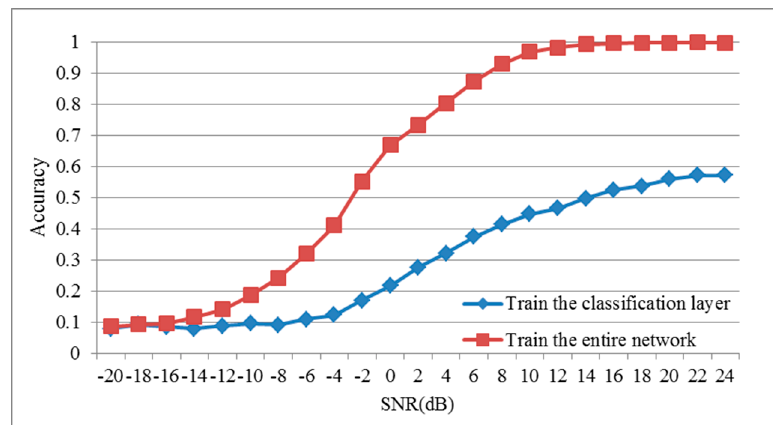
Figure 4. Performance comparison between training the entire network and training only the classification layer. The classification method is signal rearrangement method (SRM), the model used is Resnet18, and the dataset is